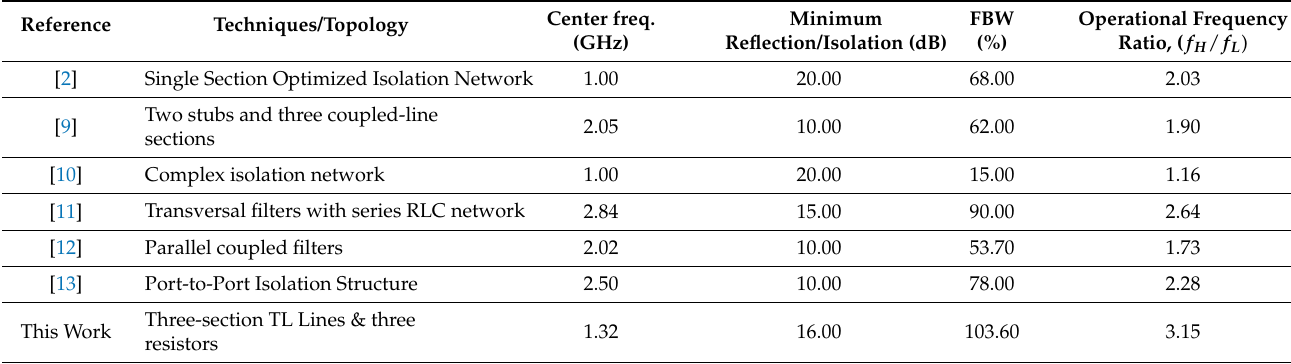
Figure 7. The simulated and measured phase difference in degrees. Table 2. Comparison of the proposed design methodology and previous